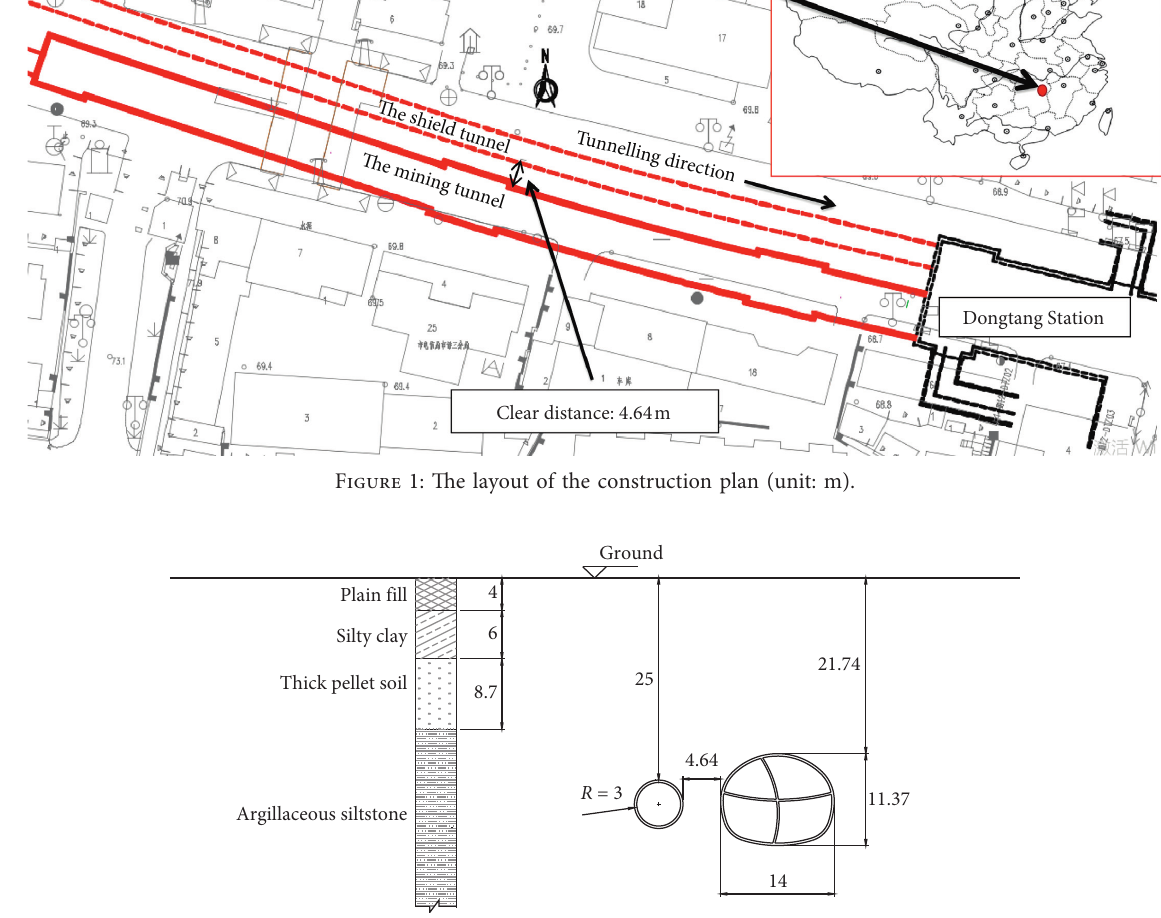
Figure 2: Schematic diagram of the cross-section arrangement of tunnels (unit: m). Table 1: Stratigraphic physical and mechanical